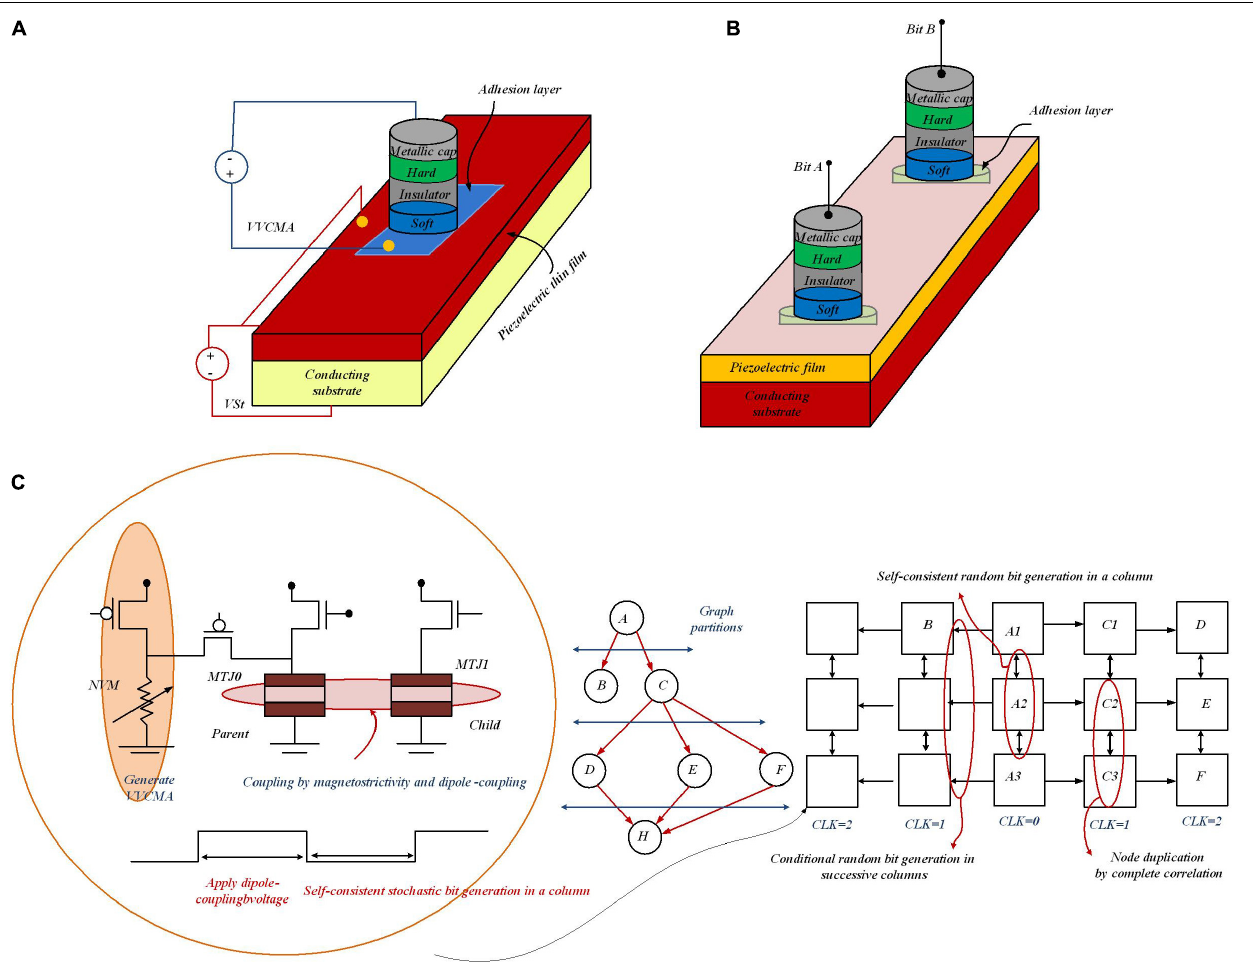
FIGURE 11 | Stochastic random number generation utilizing MTJs with programmable probability. (A) MTJ with VCMA and STT (applied via the voltage V VCMA ). For programmable random number generation, the magnetostriction, i.e., strain (controlled with the voltage V St ) can be co-optimized. (B) MTJ integration utilizing the effect of dipole coupling (controlled with local stress applied to one MTJ) can be used to couple the switching probability of one MTJ depending on the state of the other. Thereby, the correlation between the bits “ A ” and “ B ” can be controlled via the resistance states of the two MTJs. (C) MTJ network-based Bayesian reasoning machine to show an example mapping of Bayesian graph on 2D nanomagnet